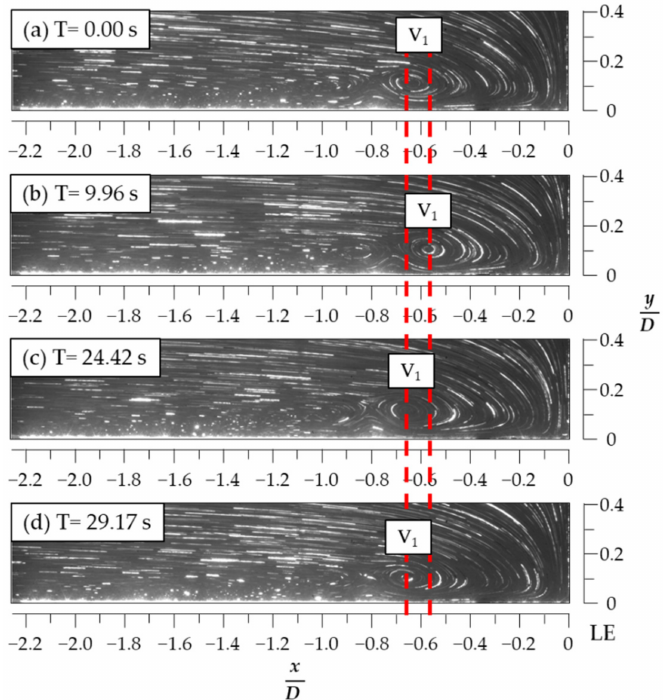
Figure 4. Time-series flow visualization of the HSV’s kinematic mode: “oscillation with a small displacement” in the z = 0 cm plane when H / D = 0. The two red dashed lines indicate the oscillation range of the core of the HSV closest to the LE (labeled V 1 ) between x / D = − 0.57 and −